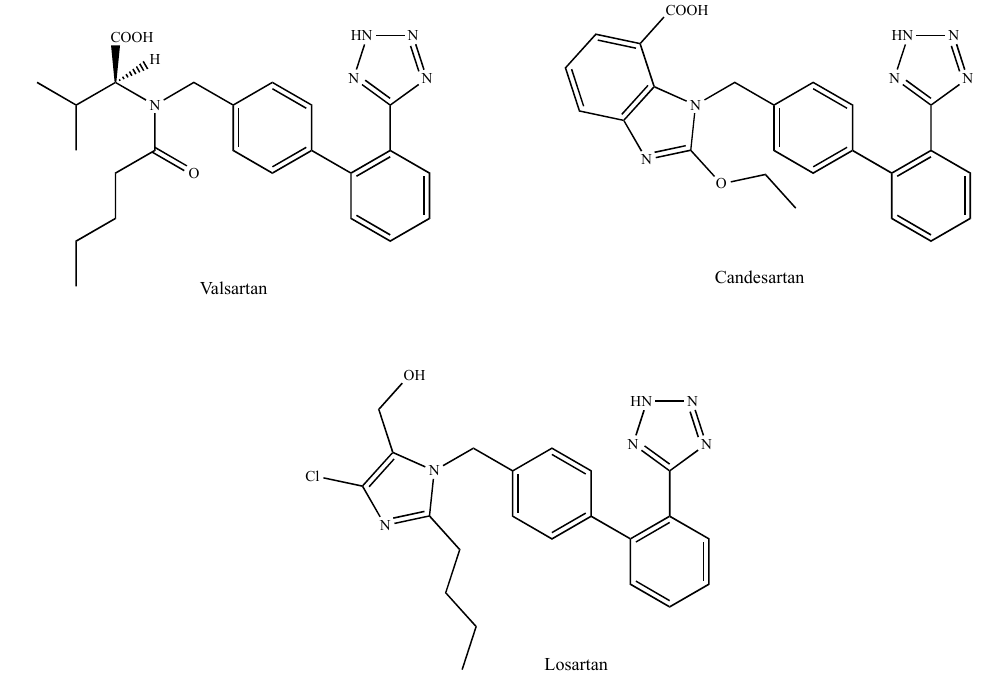
Figure 7. Structure of the AT1R antagonists valsartan, candesartan and losartan.